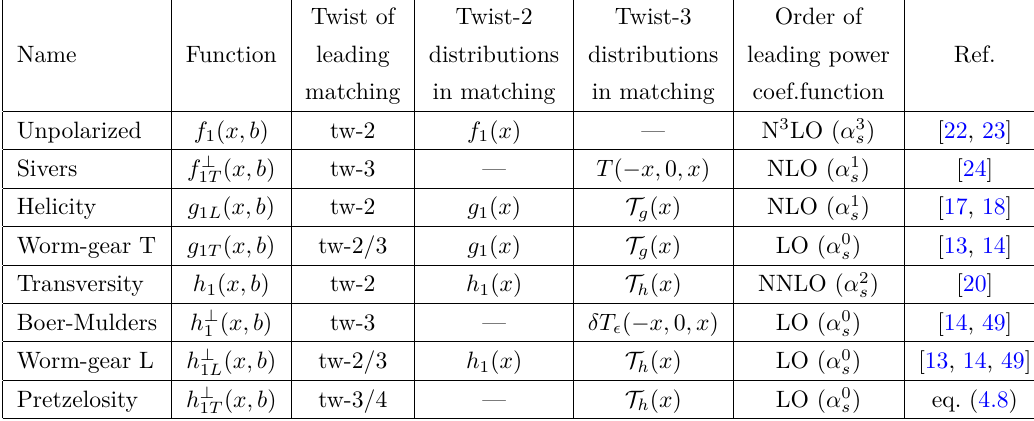
Table 1 . Summary of the information on the collinear matching for quark